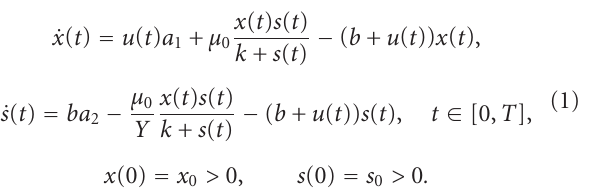
a necessary, but also a su ffi cient optimality condition [15].